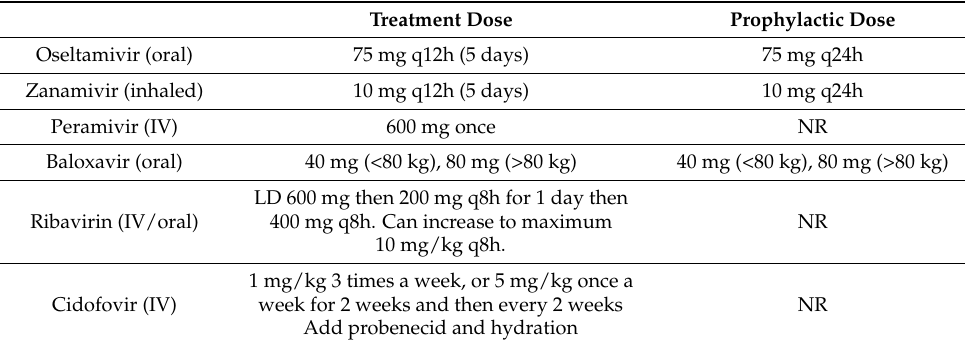
Table 2. Dosing of commonly used